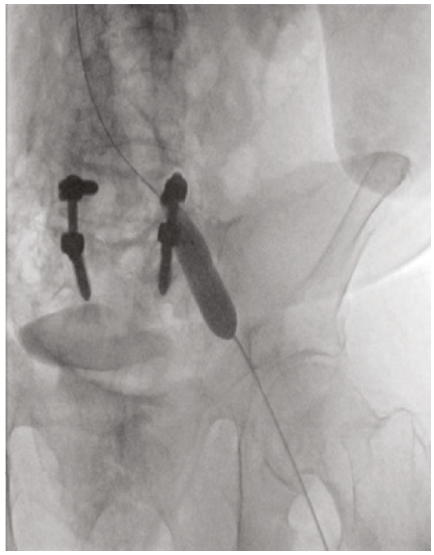
Figure 5: Fluoroscopy showing percutaneous transluminal angioplasty of the left iliac